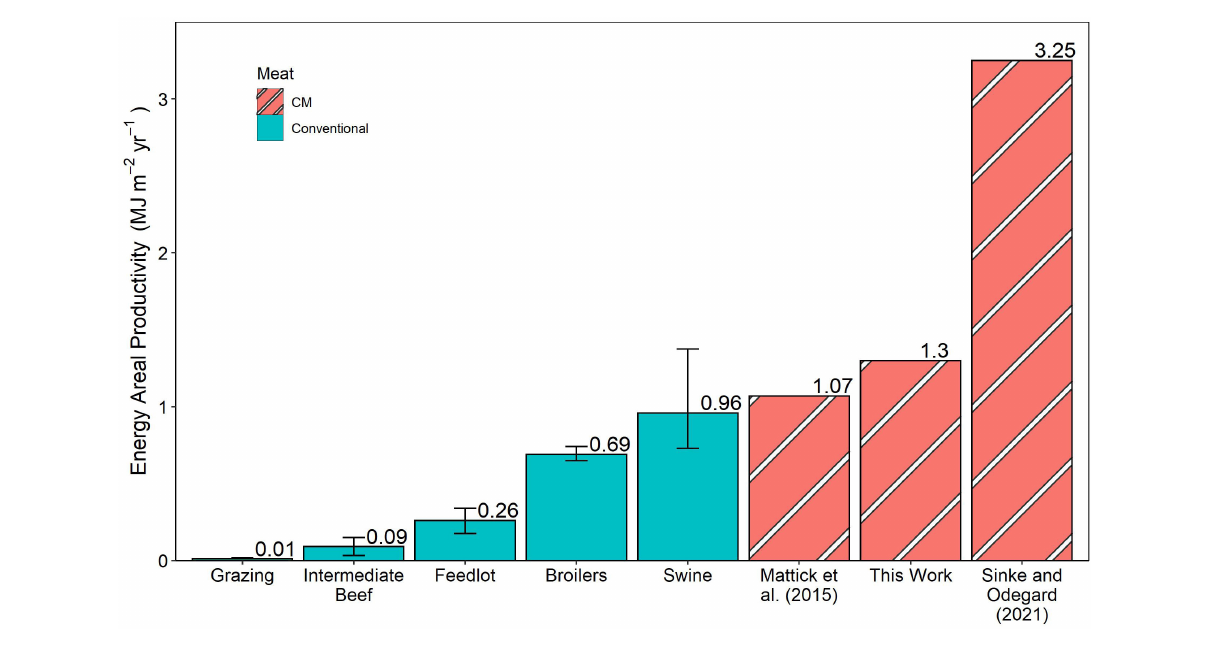
FIGURE2 Energy areal productivity in this calculated in this work, calculated from published land uses in CM life cycle analyses, and from published land uses of conventional meat products shown in MJ m - 2 year - 1 . Error bars represent the range of published land use values in conventional meat